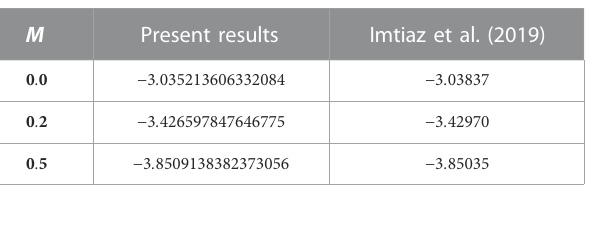
TABLE 3 Comparison of skin friction.